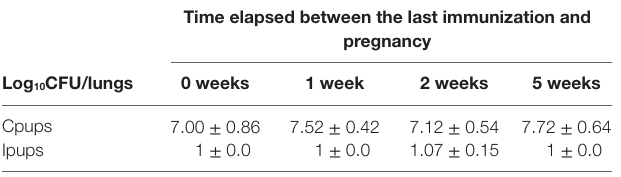
TaBle 1 | Protection of offspring through maternal immunization before pregnancy.